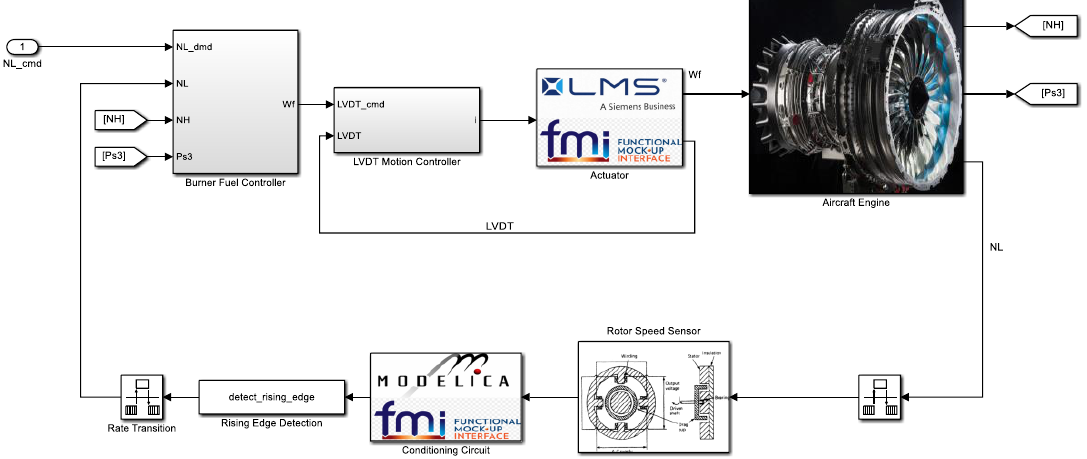
Figure 19. Full-Digital co-simulation (Simulink Master).